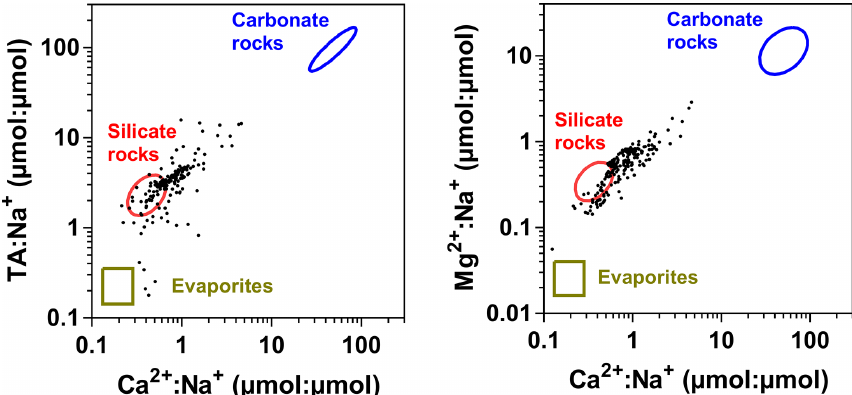
Figure 18. Total alkalinity (TA) and Mg 2 + as a function of Ca 2 + of the surface waters of rivers and streams of the Congo River network, in Na + normalized plots (µmol:µmol) showing the composition fields for rivers draining different lithologies from a global compilation of the 60 largest rivers in the world (Gaillardet et al.,